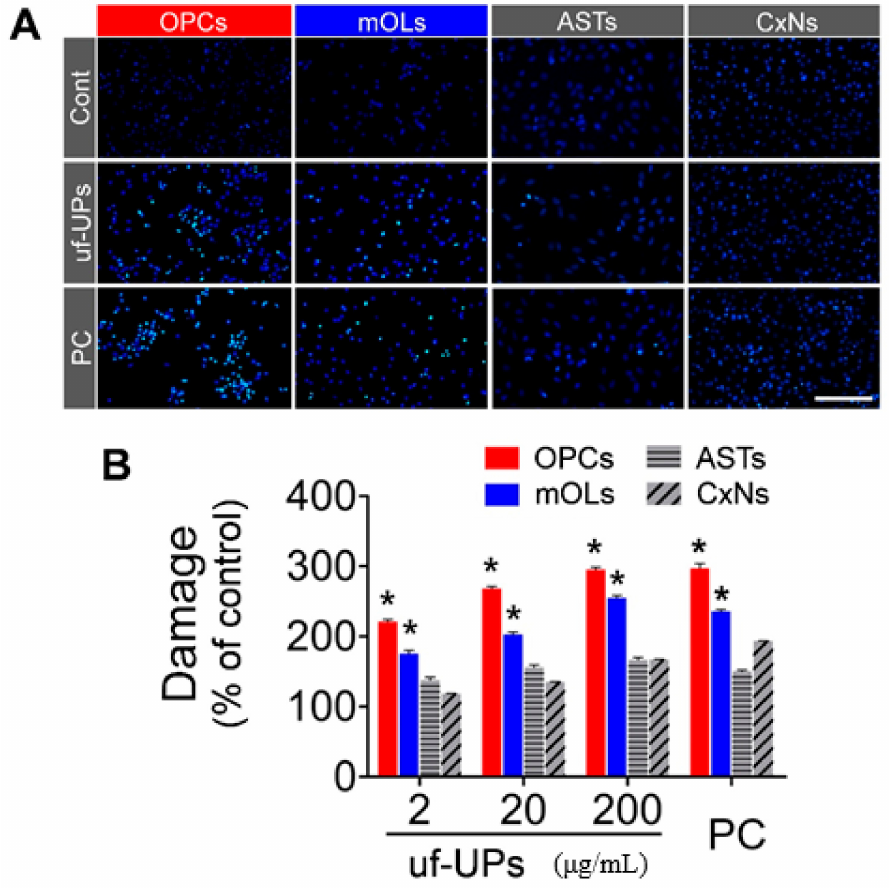
Figure 3. Cell damage analysis using Hoechst staining. ( A ) Hoechst staining. A large number of damaged OPCs and mOLs are visible after uf-UP exposure (200 µ g/mL). ( B ) Comparison of damaged cells under various uf-UP concentrations. A significantly greater proportion of OPCs and mOLs than ASTs and CxNs are damaged by more than 2 µ g/mL uf-UP exposure. Hydrogen peroxide (H 2 O 2 , 100 µ m) is used as positive control (PC). Note that the damage rate of each cell type at 200 µ g/mL uf-UPs is similar to the rate at 100 µ m hydrogen peroxide. Data are expressed as percentage of the control and represent mean ± SEM ( n = 8). * p < 0.05 vs. ASTs and CxNs. Scale bar = 200 µ